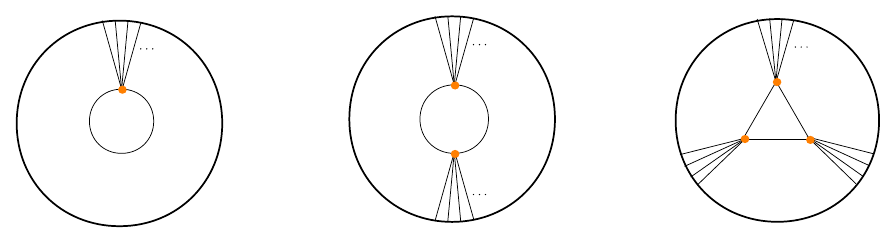
Figure 6 . AdS d +1 Witten diagrams contributing to the first heat kernel coefficients. Internal lines can either have Dirichlet ( ∆ ) or Neumann ( ∆ ) boundary condition. In the latter case each + − internal line can be further decomposed into a Dirichlet line and a boundary